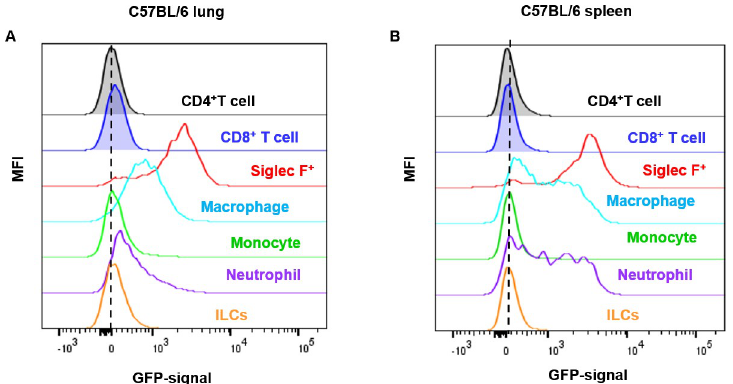
Fig 3. The cell-type-specific autofluorescence in C57BL/6 mice in control conditions. Representative histograms from the (A) lung and the (B) spleen of PBS challenged C57BL/6 mice, demonstrating the increase in autofluorescence in the GFP-channel for myeloid cells. The graphs show representative data from three independent experiments (PBS: n = 9 mice/group, LPS: n = 13–15 mice/group in total).